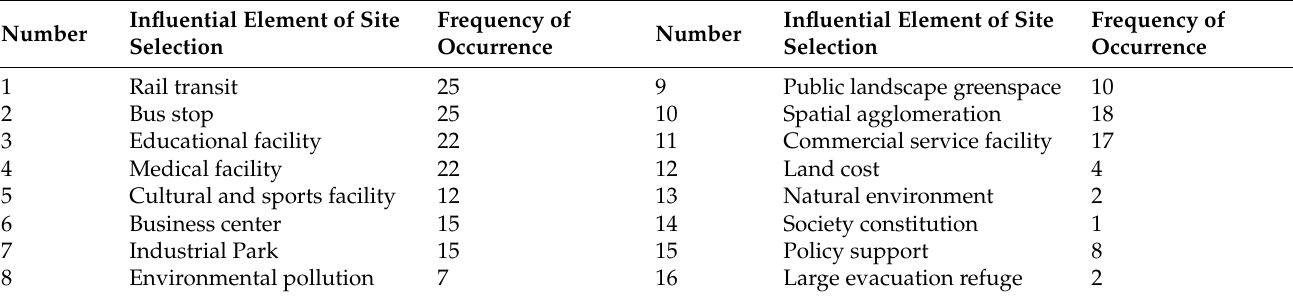
Table 3. Summary of site selection influential